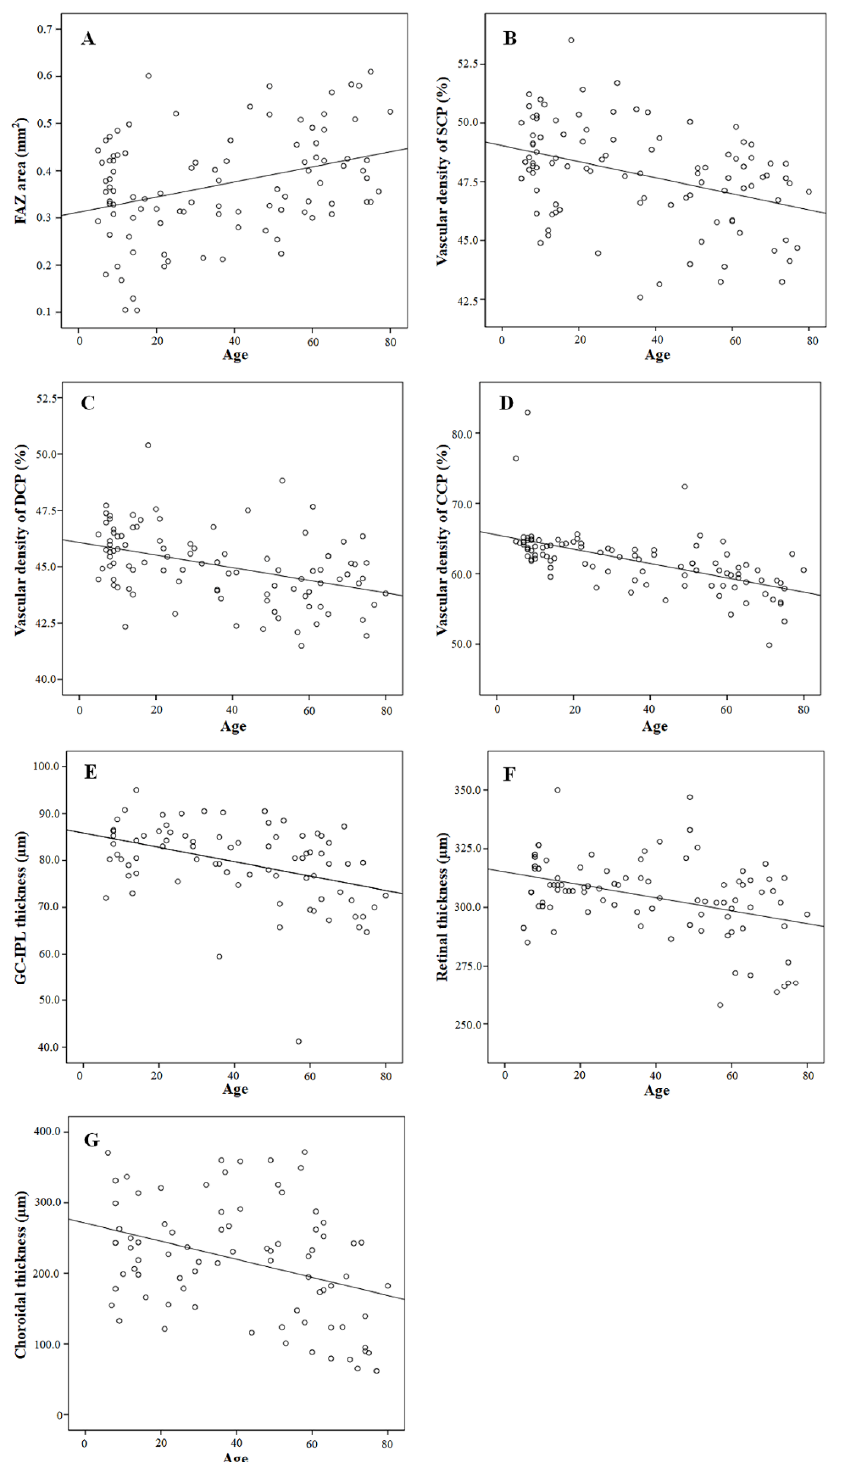
Figure 3. Correlation between age and other variables. The FAZ area was positively correlated with age (R = 0.350, p < 0.001) ( A ). Figures B–G show correlations between age and OCTA and OCT variables of the parafoveal region of the ETDRS grid. The VD of the SCP (R = − 0.388, p < 0.001) ( B ), VD of the DCP (R = − 0.420, p < 0.001) ( C ), VD of the CCP (R = − 0.590, p < 0.001) ( D ), GC-IPL thickness (R = − 0.412, p < 0.001) ( E ), RT (R = − 0.409, p < 0.001)( F ), and CT (R = − 0.354, p < 0.001) ( G ) were negatively correlated with age.